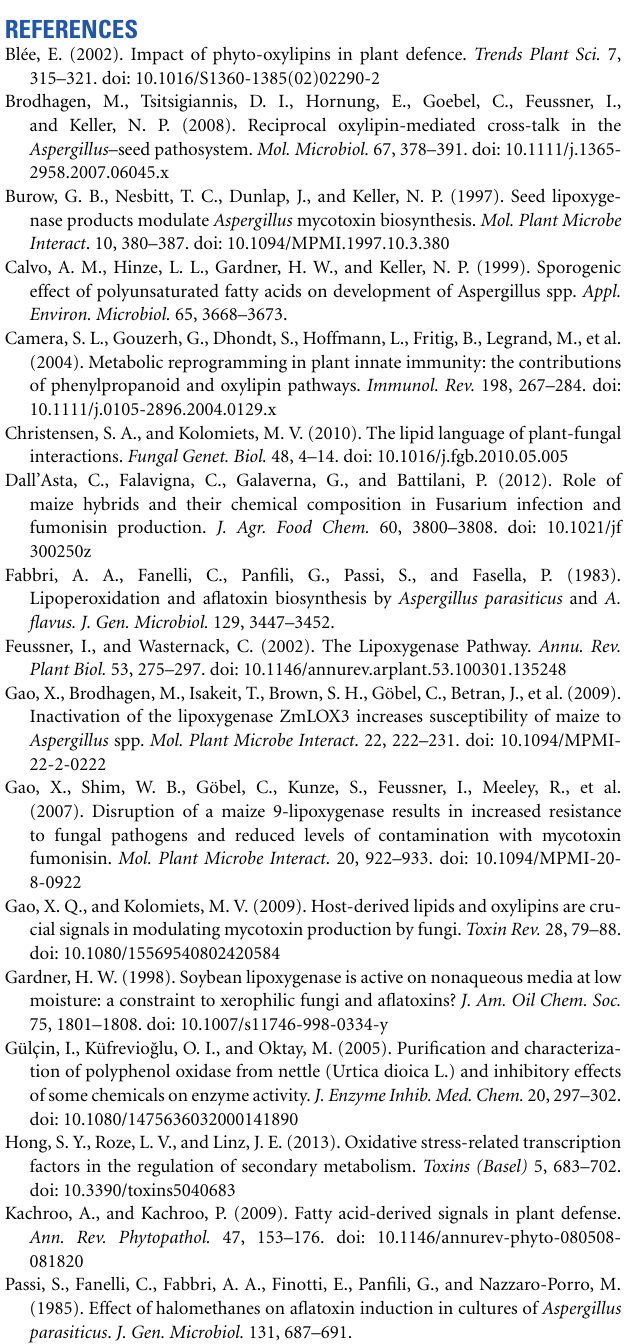
Figure S2 | PCA score plot of data generated by HPLC-ESI/TOF-MS analysis of of lipid extract of maize kernels non-inoculated or inoculated with AFC-1 (WT) and the 3 deleted Af lox1 strains (1.1/3.2/5.1) at 3, 7, 10 and 14dpi. The results of the PCA analysis referred to three separate experiments performed in duplicate. Figure S3 | Eulero–Venn’s diagram showing compounds differences present in maize kernels inoculated with AFC-1 (WT) or the 3 deleted Af lox1 strains. The labels of each circle report the number of compounds selected on the basis of significant difference and 100% frequency in at least one